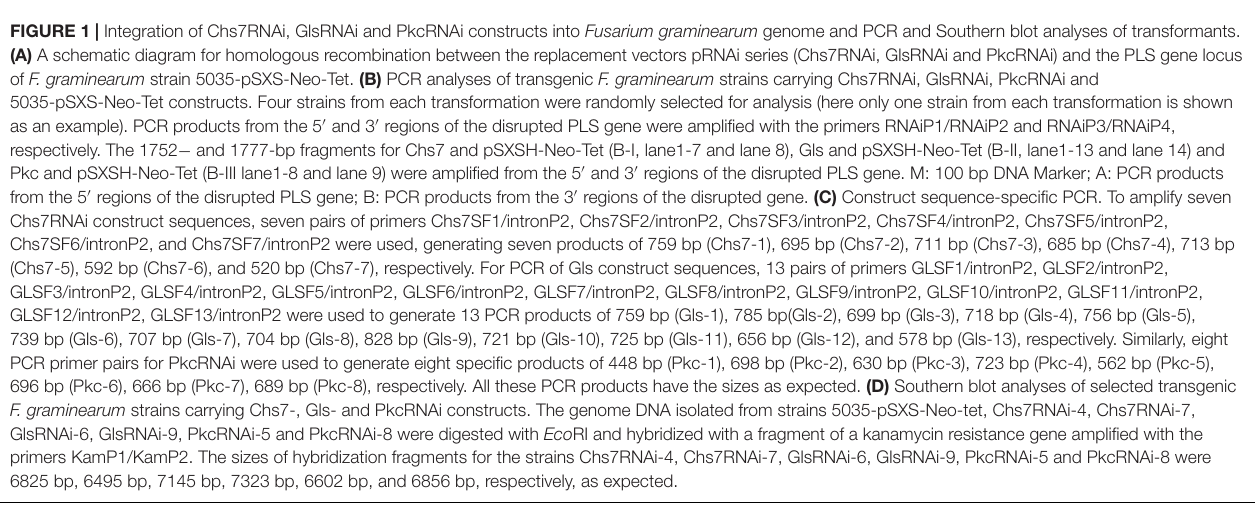
Frontiers in Microbiology |